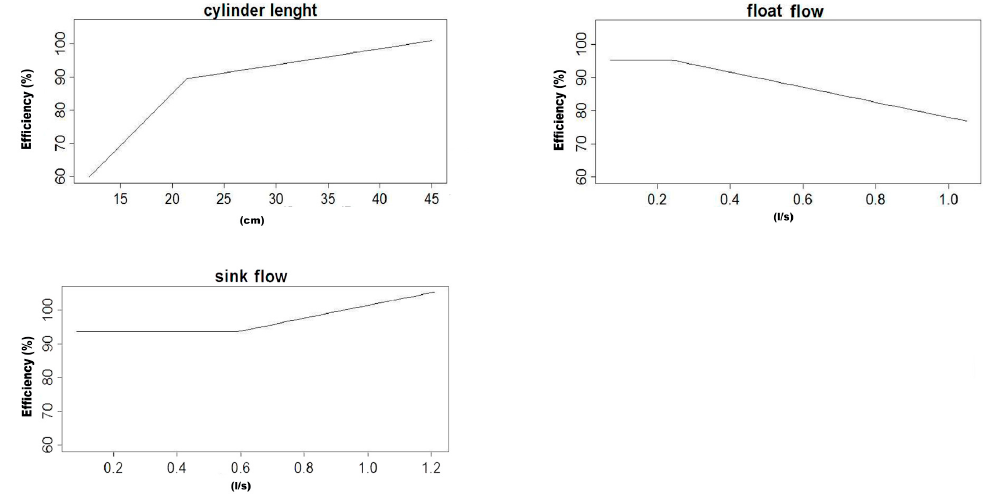
Figure 3. Graphical representation of the basis functions of MARS model number one and their coefficients for feed into the vortex.